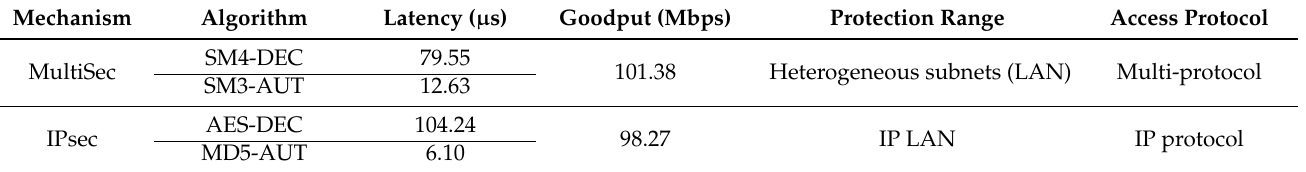
Table 2. The comparison of MultiSec and